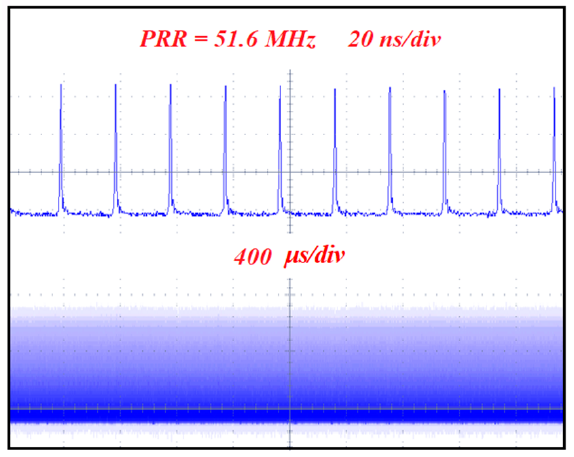
Figure 6. Pulse train of the CW mode-locking Nd:GLNO crystal laser.